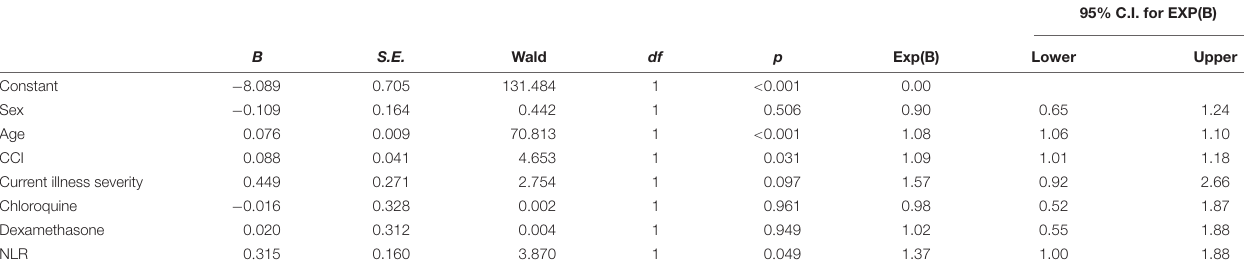
TABLE 2 | Prediction of NLR on delirium development adjusting for